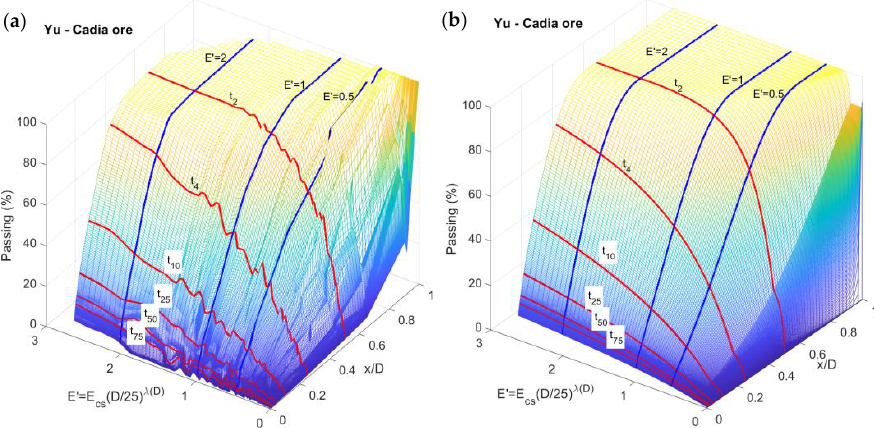
Figure A13. 3D breakage plots for Yu’s [ 26] Cadia ore. (a) from data. (b) from double fan model (direct fit, variable 𝜆 ).